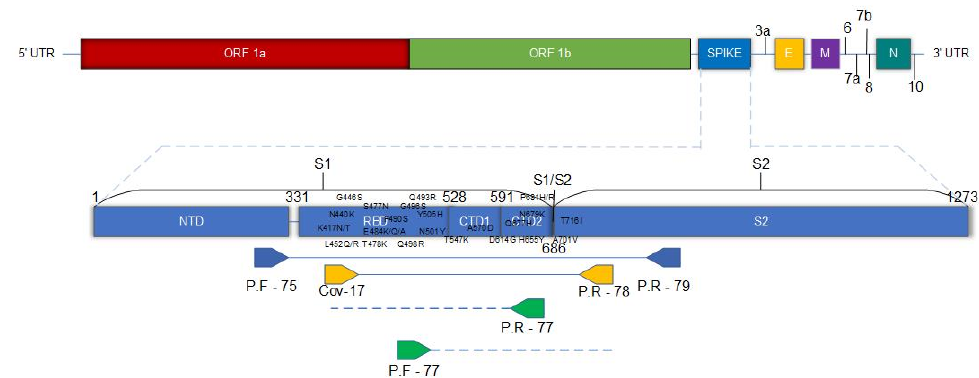
Figure 2. Primer placement and detection coverage. Positioning of the amplification and sequencing primers within the S gene. The positioning of the primers allows identification of the 25 mutations signaled in the image. The first round of PCR (primer forward 75 and primer reverse 79) amplifies an extensive region of the gene, covering the entire portion of RBD up to the initial portion of the S2 subunit. The product of the second round (Primer Forward CoV-17 and Primer Reverse 78) delimits the region for sequencing and identification of mutations.